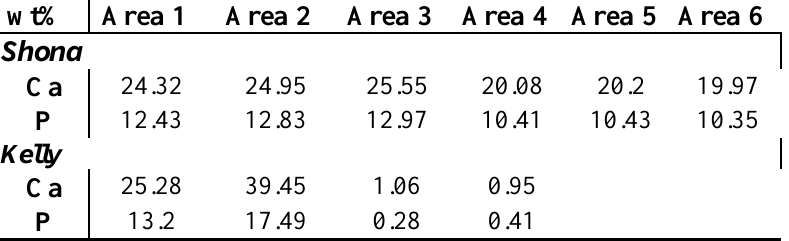
Table 2 . Composition (weight percentages) of calcium (Ca) and phosphorus (P) in different regions of dental tissues from Shona and Kelly . See Fig. 4 for location of